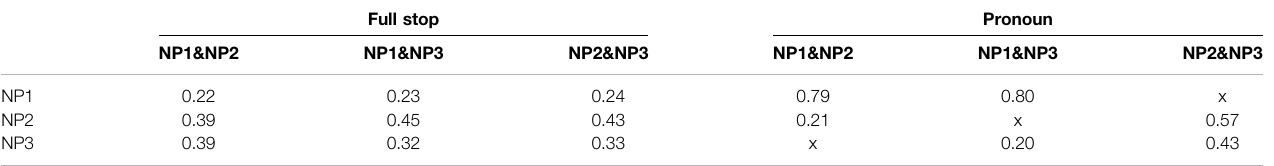
TABLE10| Proportionofnext-mentioninExperiment3,perreferent,perprompttype,perambiguouspair.Thevaluesineachcolumnsumtoone(e.g.,there-mentionrates in the full-stop NP1&NP2 condition are distributed 0.22/.39/.39 across the three referents).